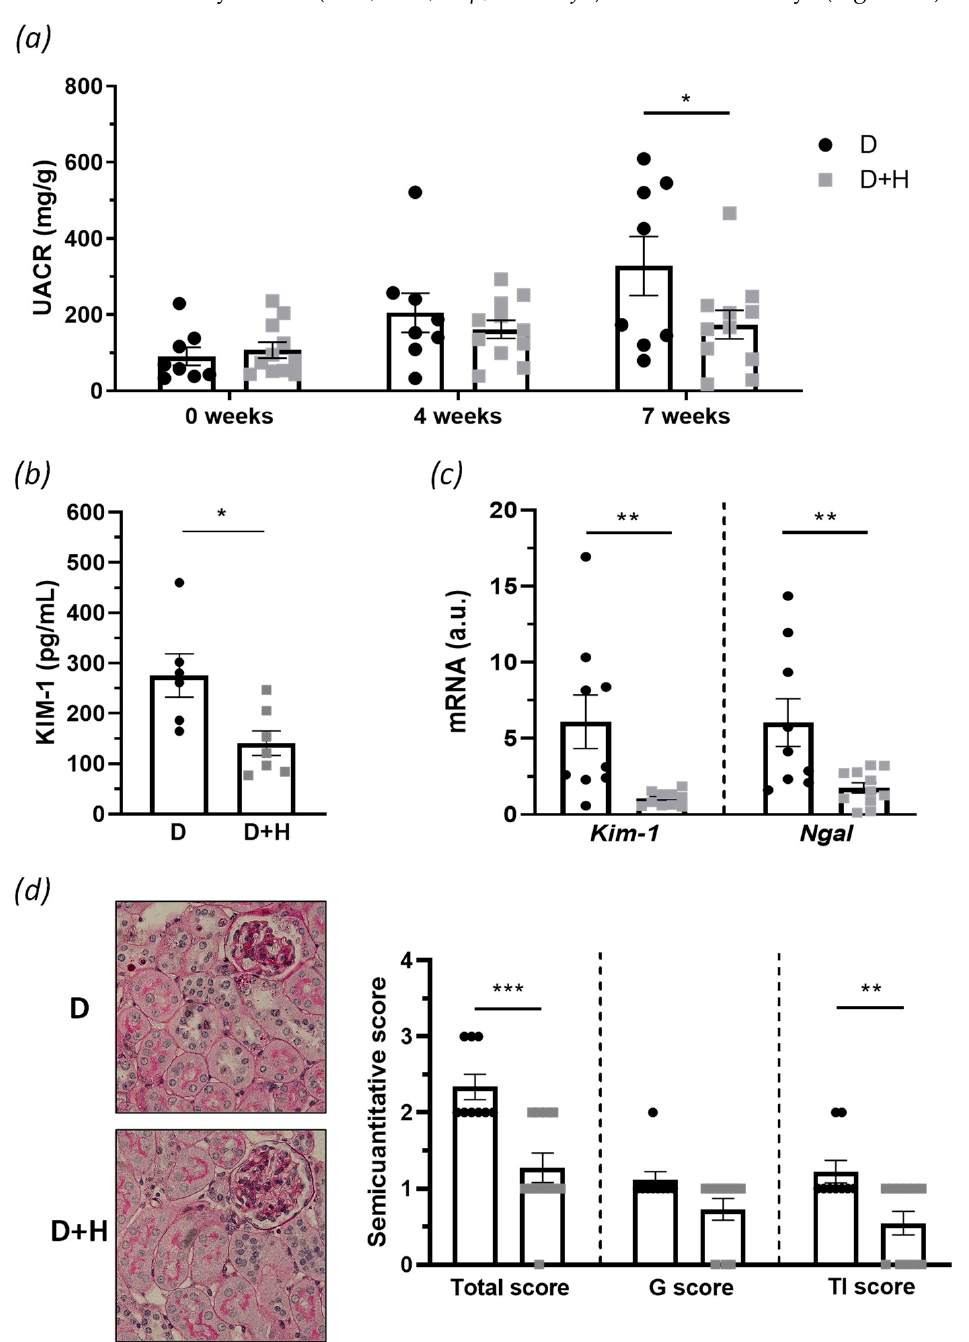
Figure 3. In vivo assessment of hidrosmin effect in experimental DN: ( a ) evolution of UACR levels in diabetic groups (control, D; hidrosmin-treated, D + H) along the study; ( b ) KIM-1 protein concentration in urine samples at final point; ( c ) real-time PCR analysis of Kim-1 and Ngal in renal cortex. Values normalized by 18S are expressed in arbitrary units (a.u.); ( d ) representative images of PAS staining (magnification × 400) and assessment of glomerular (G), tubulointerstitial (TI), and total kidney semiquantitative score. Scatter dot plots represent individual values and the mean ± SEM of n = 6–9 animals (D group) and n = 7–11 animals (D + H group). * p < 0.05, ** p < 0.01, and *** p < 0.001 vs. D.